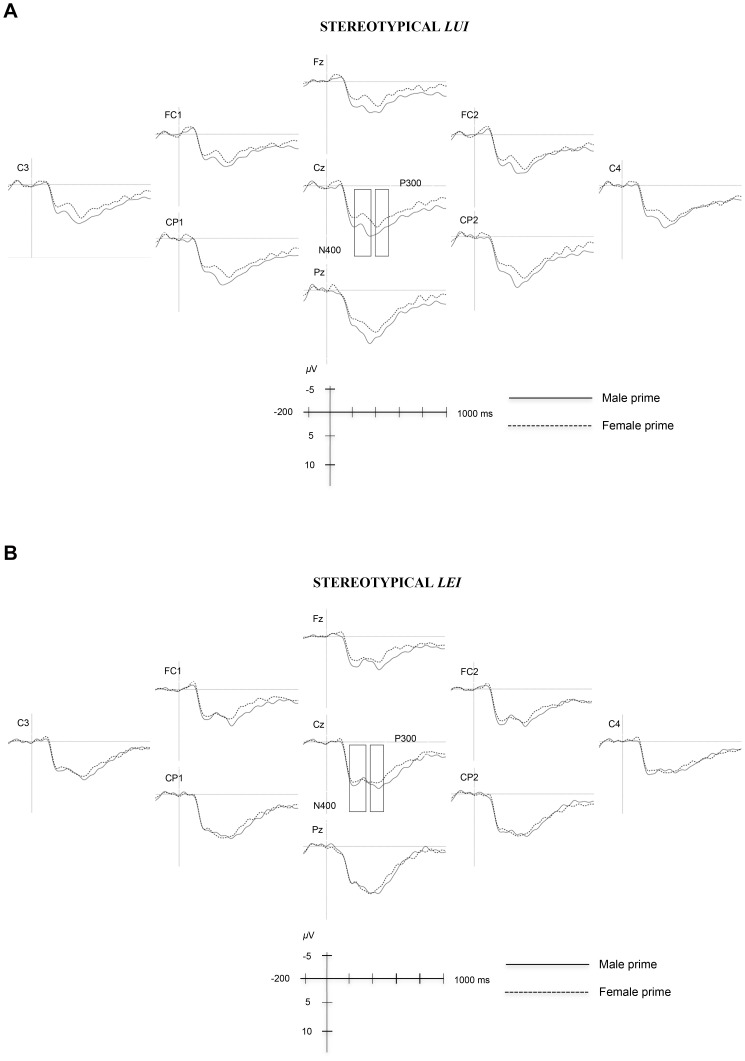
Mean amplitudes evoked by masculine pronouns (lui – “he”) (A) and feminine pronouns (lei – “she”) (B) after male and female stereotypical primes (n = 25). Zero point is the onset of the pronoun. Amplitudes are provided for representative electrodes only. Negativity is plotted upwards.